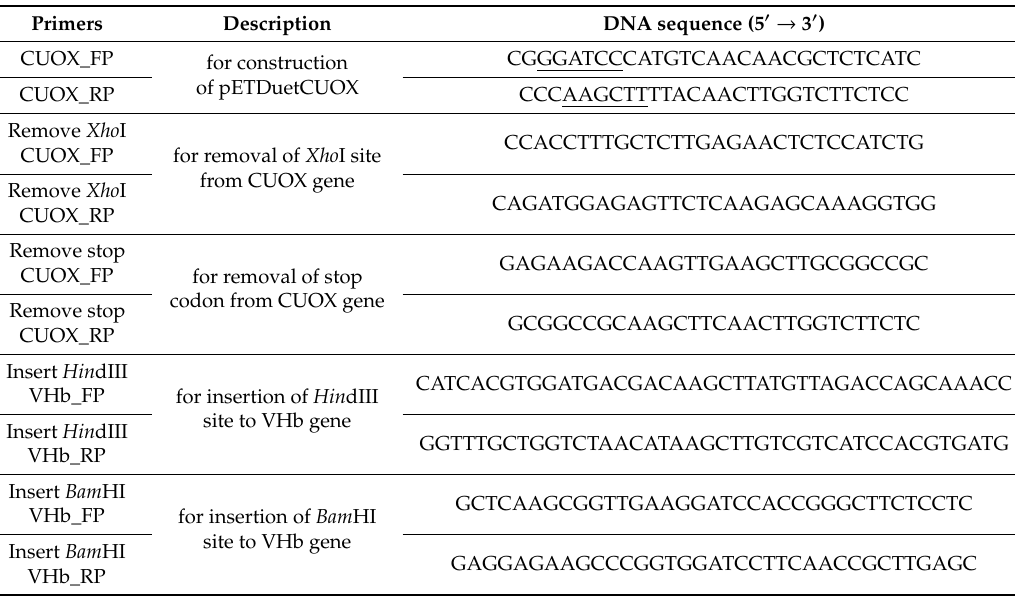
Table 6. Primers for PCR amplification and site-directed mutagenesis. Bam HI and Hin dIII restriction sites were included in CUOX_FP (forward primer) and CUOX_RP (reverse primer), respectively. The restriction sites are indicated as underlined